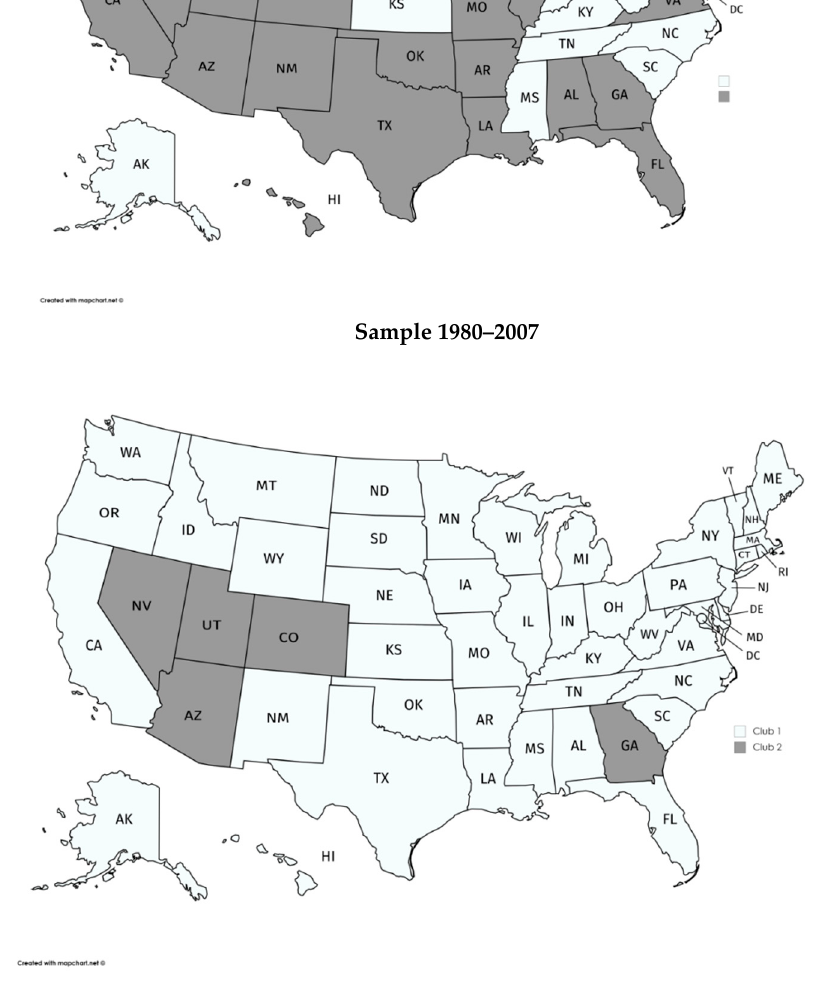
Figure 1. Estimated clubs for real per capita Personal Health Care Expenditure.